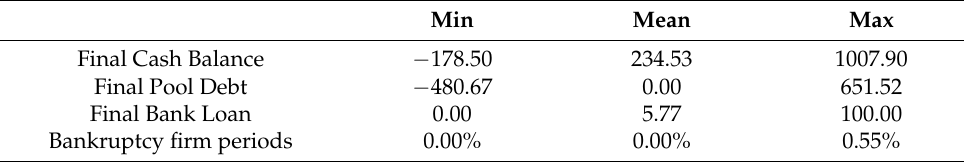
Table 16. Results for diverse operational risk and interest rates with cooperation.